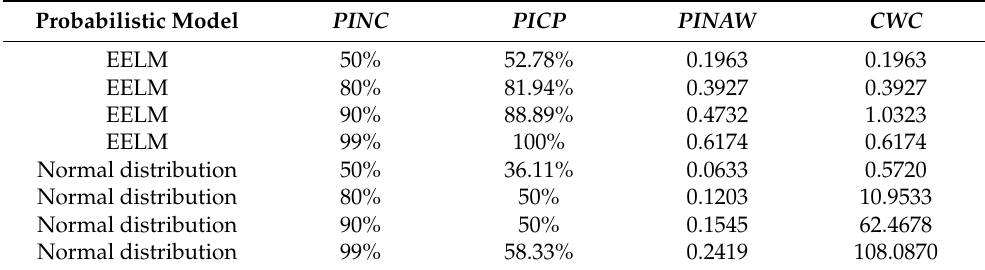
Table 4. Confidence interval evaluation index for time period 11–12 h.